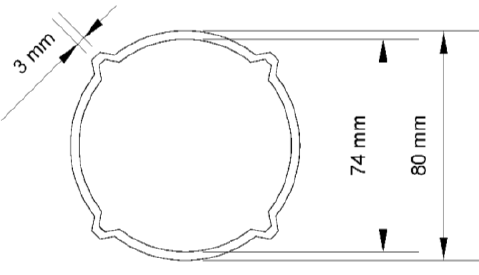
Figure 4. Cross-section of inclinometer casing.